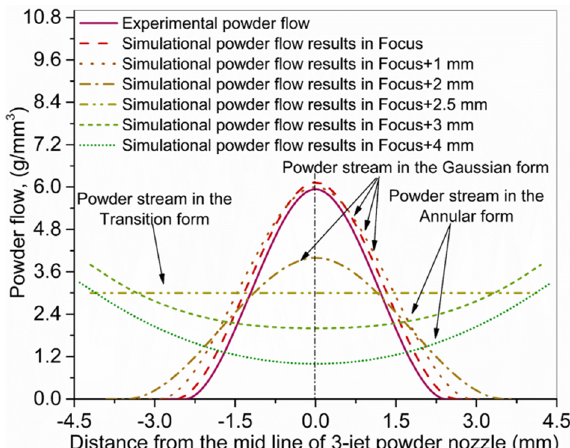
Figure 6. Comparison of Ti6Al4V titanium alloy powder flow experimental and simulation results: Influence of the focal point position on powder stream distribution regimes.